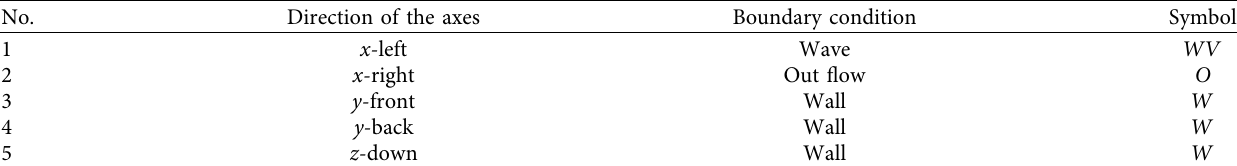
Figure 2: Four 2D view model of sloping and curved seawalls. Table 3: The boundary conditions and their symbols were used in this research.